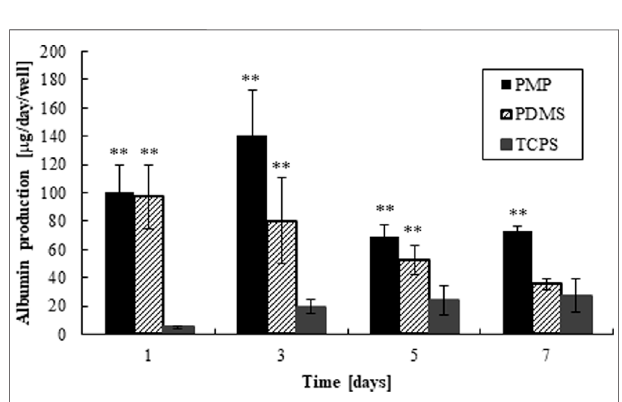
FIGURE 4 | Albumin production of hepatocytes cultured on PMP, PDMS, and PDMS plates, respectively (**: p < 0.01, N = 6, vs. TCPS).